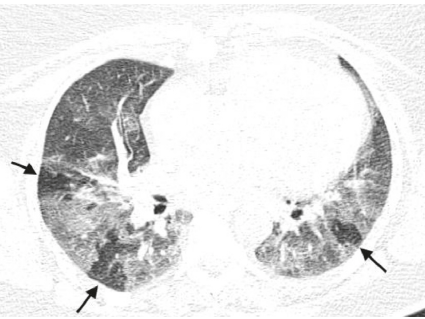
Figure 3: Chest CT in a lung window. Expiratory apnoea. An axial section at the level of the lower lobes highlights areas of air trapping